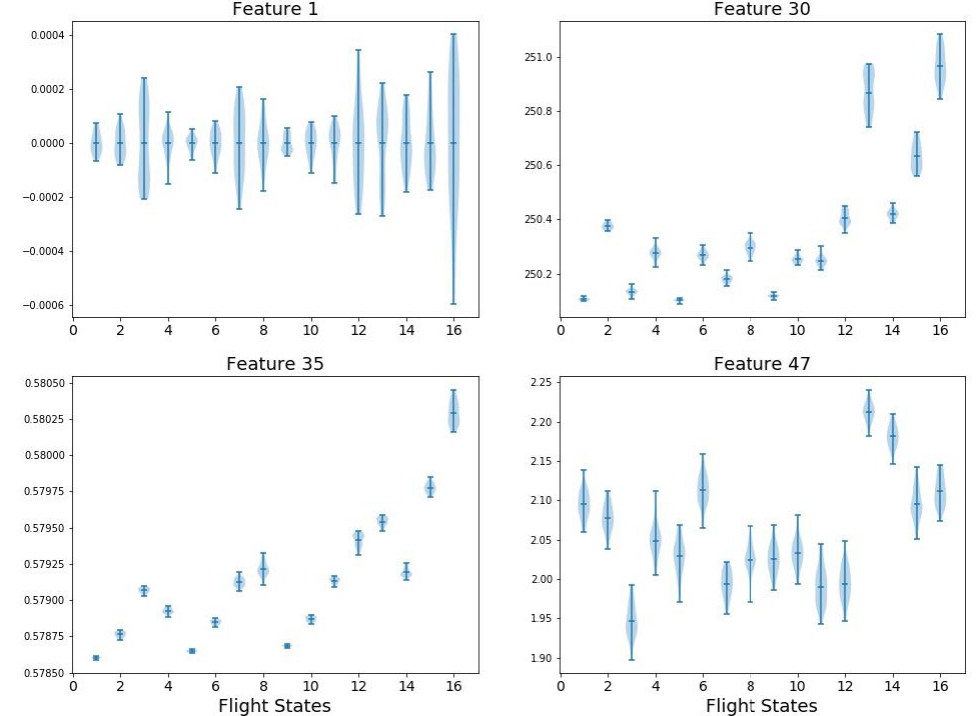
Figure 5. Pool and superior features against 16 flight states.